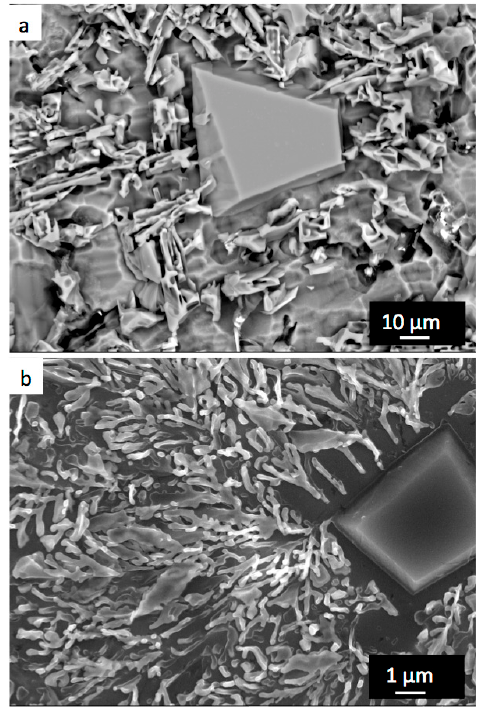
Figure4. Connectionbetweenprimaryandeutecticsiliconin( a )Al-18%Si-2%Cuand( b )Al-12%Sialloys. Metals 2020 , 10 , x FOR PEER REVIEW Figure 4. Connection between primary and eutectic silicon in ( a ) Al-18%Si-2%Cu and ( b ) Al-12%Si alloys.